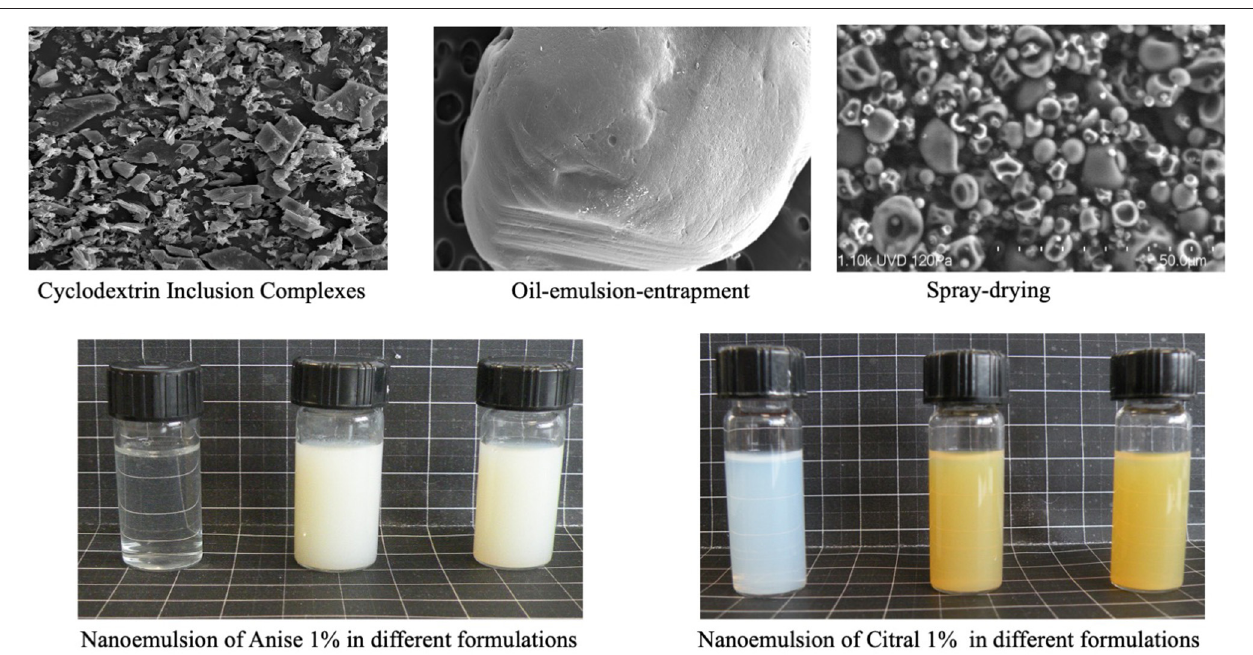
FIGURE 1 | Micro/nanoencapsulation techniques for solid formulations (cyclodextrin inclusion complexes, oil-emulsion-entrapment, and spray-drying) and liquid formulation (nanoemulsions).